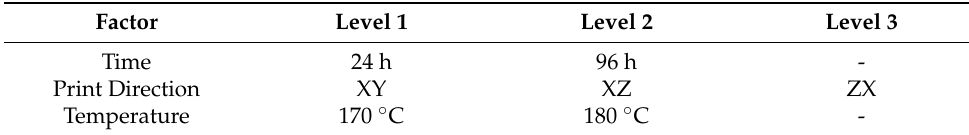
Table 2. Factors used in modified L9 orthogonal array.